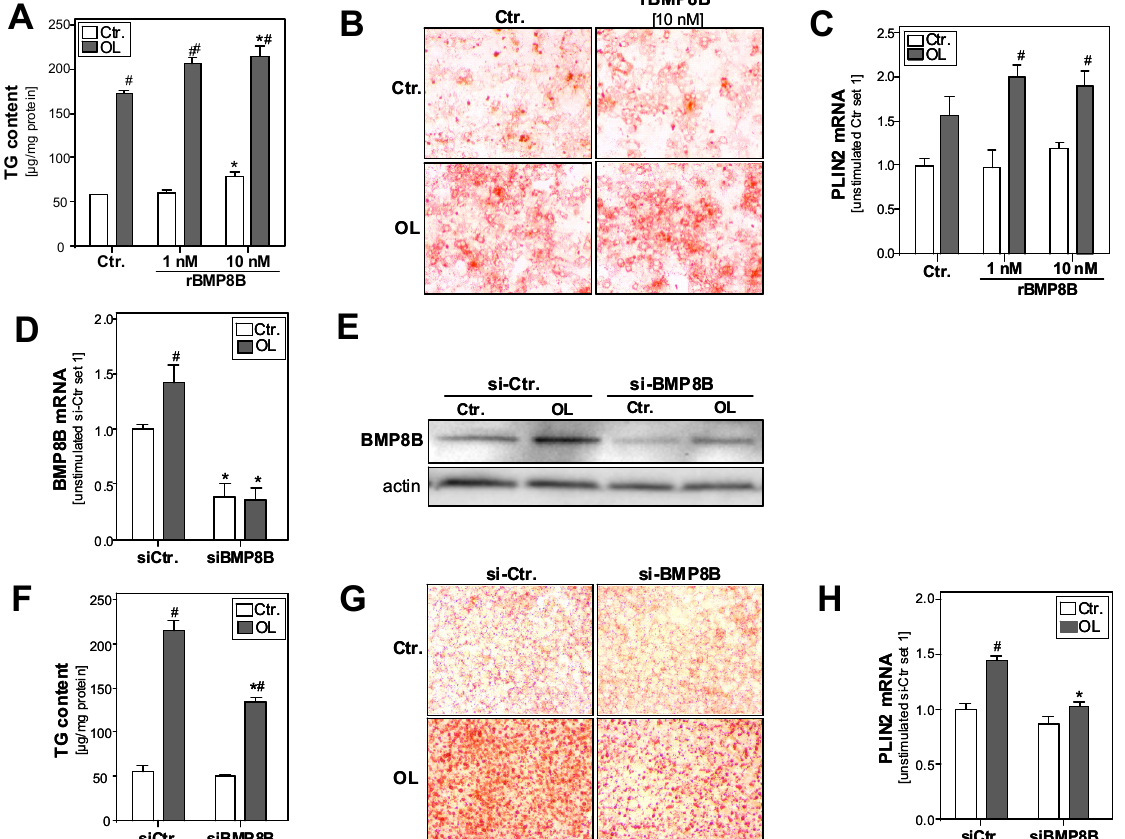
Figure 2. E ff ect of BMP8B (depletion) on hepatocellular steatosis in vitro. ( A – C ): PHH were incubated with oleate (OL; 0.4 mM) for 24 h in the presence or absence of recombinant BMP8B (rBMP8B, 1 nM or 10 nM). ( A ) Hepatocellular TG content normalized to protein content; ( B ) Microscopic images (20 × ) of Oil red O staining; ( C ) PLIN2 mRNA levels analyzed by quantitative RT-PCR, (* p < 0.05 compared with the corresponding condition without BMP8B stimulation; # p < 0.05 compared with the corresponding condition without oleate stimulation using two-way ANOVA). ( D – H ): BMP8B mRNA expression was depleted in HepG2 hepatoma cells by transfection with si-RNA (si-BMP8B); control cells were transfected with control siRNA (si-Ctr). Subsequently, the cells were incubated with or without 0.4 mM oleate for additional 24 h. ( D ) Hepatocellular BMP8B mRNA levels; ( E ) Western blot analysis of BMP8B protein levels; ( F ) Hepatocellular TG content; ( G ) Microscopic images (20 × ) of Oil red O staining; ( H ) Hepatocellular PLIN2 mRNA levels analyzed by quantitative RT-PCR; * p < 0.05 compared with si-Ctr-transfected cells; # p < 0.05 compared with cells without oleate stimulation; two-way